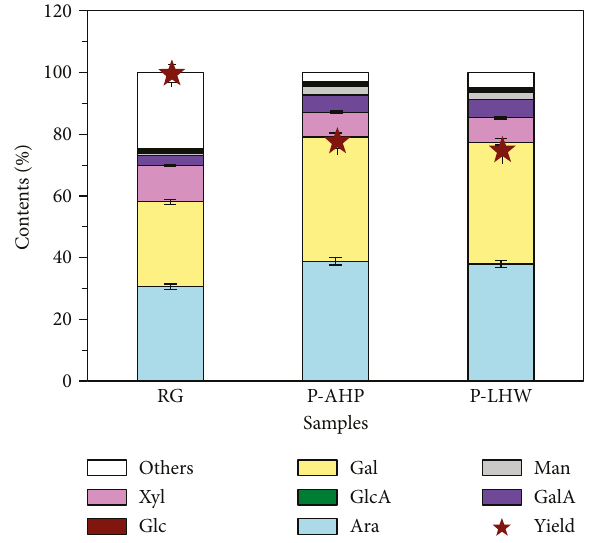
Figure 1: Yields and chemical composition of the polysaccharide fractions.